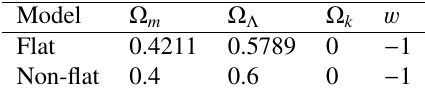
Table 2: Best fit values of Ω m , Ω Λ , Ω k and w for flat and non-flat models of Parametrization A